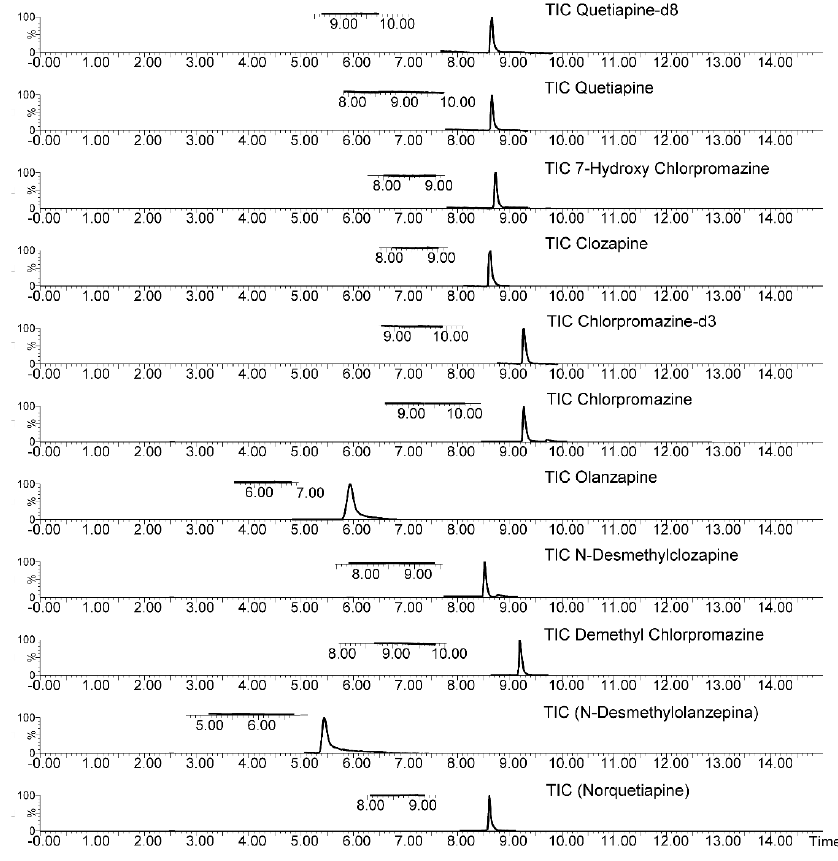
Figure 5. LC-MS / MS TIC (Total Ions Current) chromatograms of a drug-free plasma sample (subscript on the left) and drug-free plasma sample spiked with target drugs at the LLOQ concentrations.